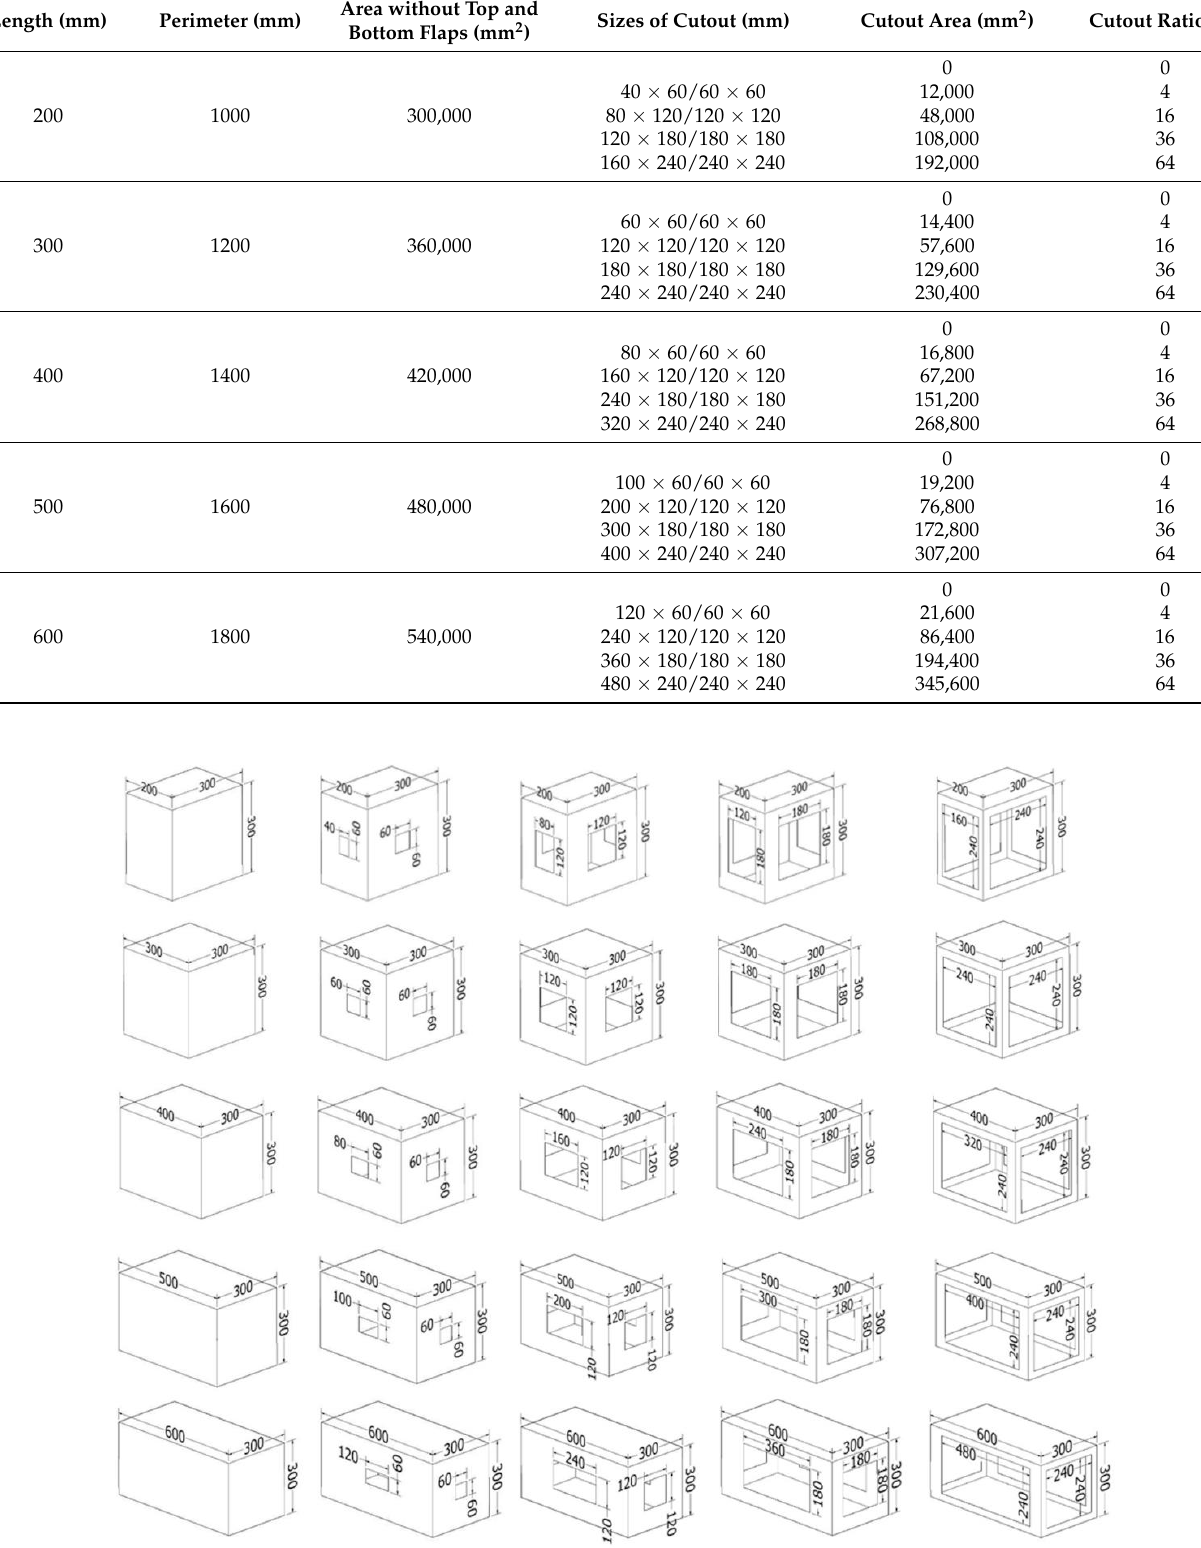
Figure 2. Five types of cutouts used on samples with different